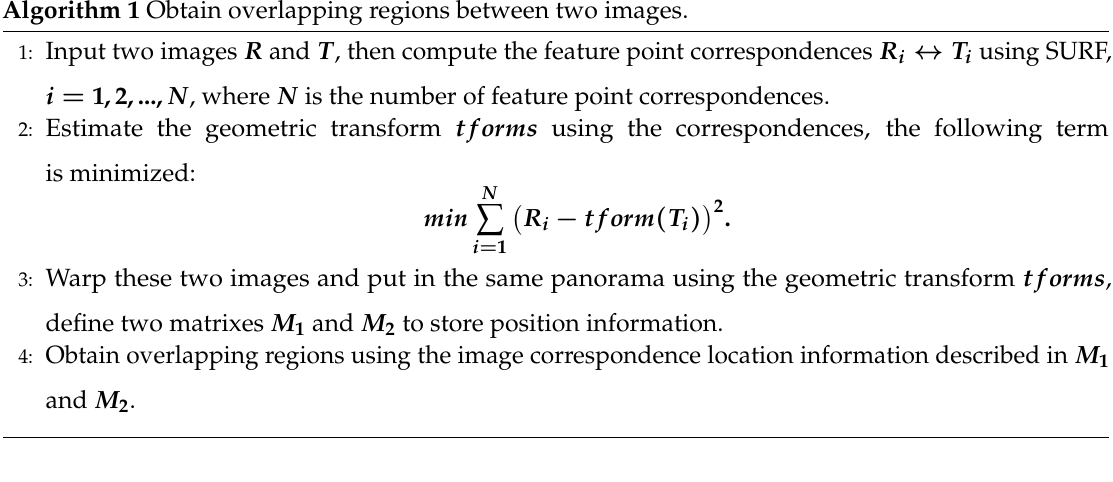
Algorithm 1 Obtain overlapping regions between two images.